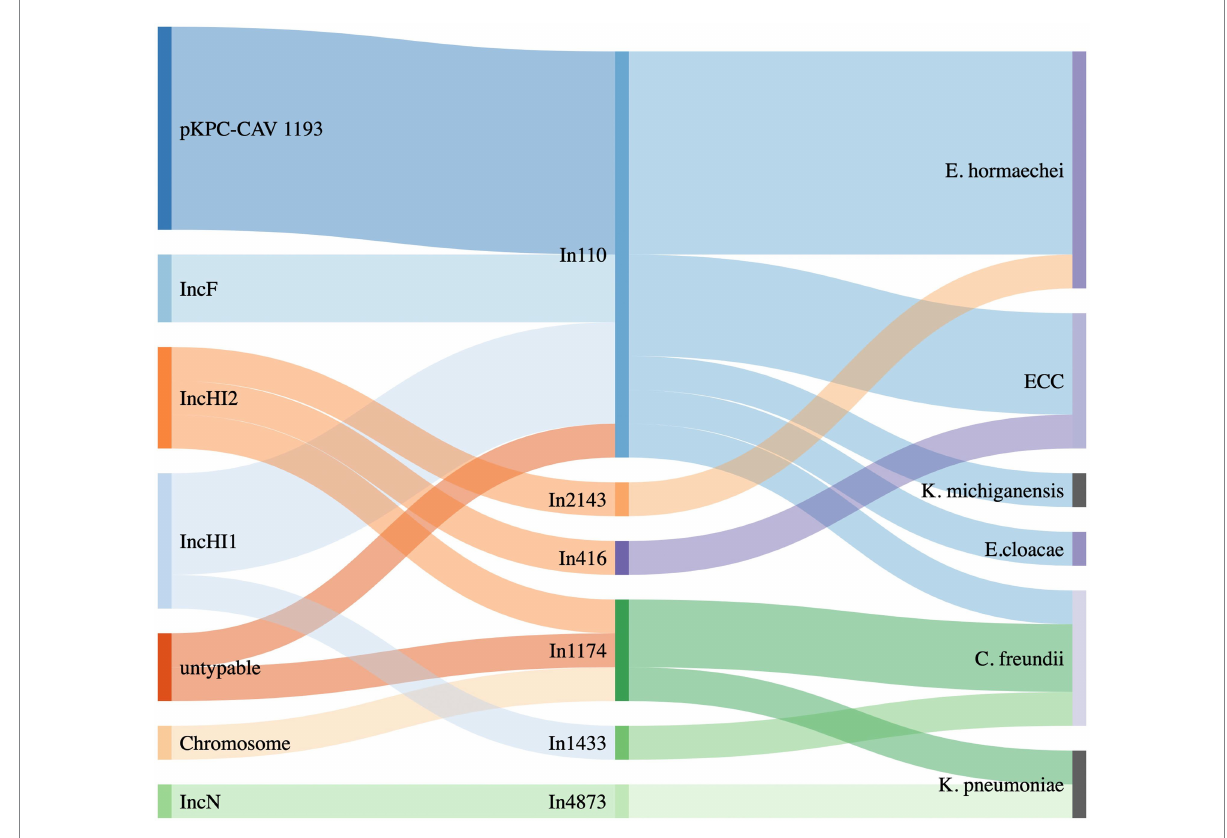
FIGURE 3 Sankey diagram showing the distribution of different integrons linking to the plasmid types (left) and to the bacterial species detected